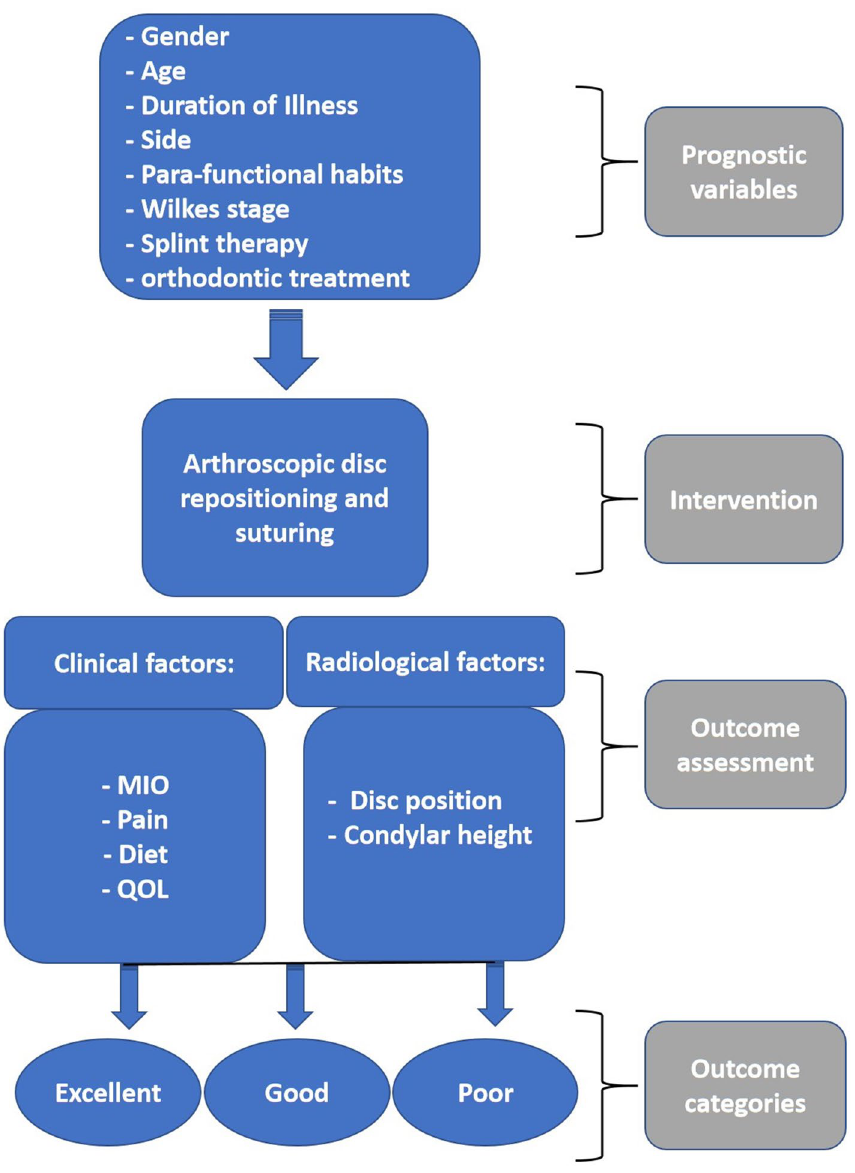
Figure 1. Study design and workflow analysis of prognostic